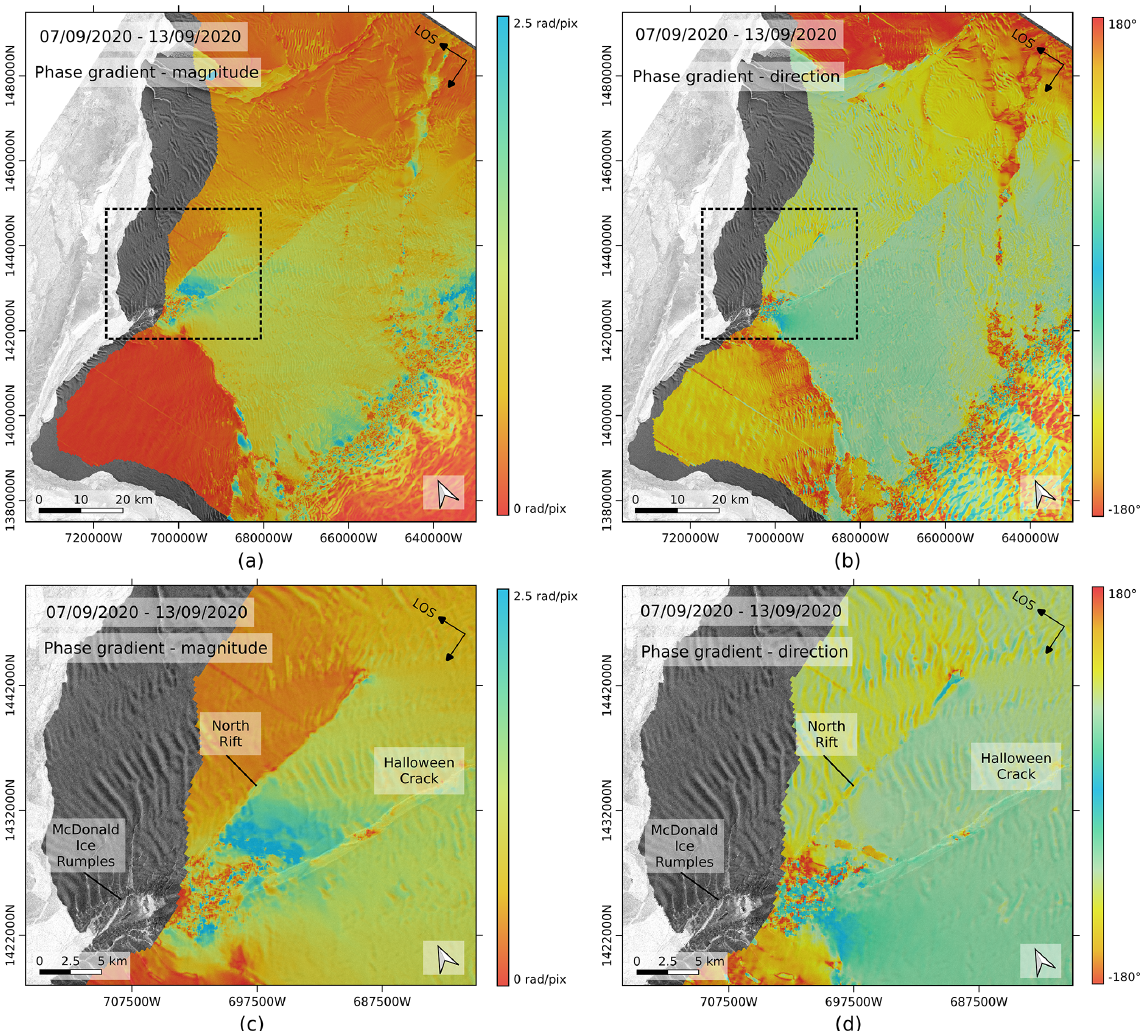
Figure 4. Phase gradient of the interferogram of 7–13 September 2020 shown in Fig. 1b. (a) Magnitude of the phase gradient. (b) Direction of the phase gradient, with angles calculated positive anticlockwise with respect to the horizontal axis. (c) Close-up view of (a) , whose extent is indicated by the black dashed frame. (d) Close-up view of (b)